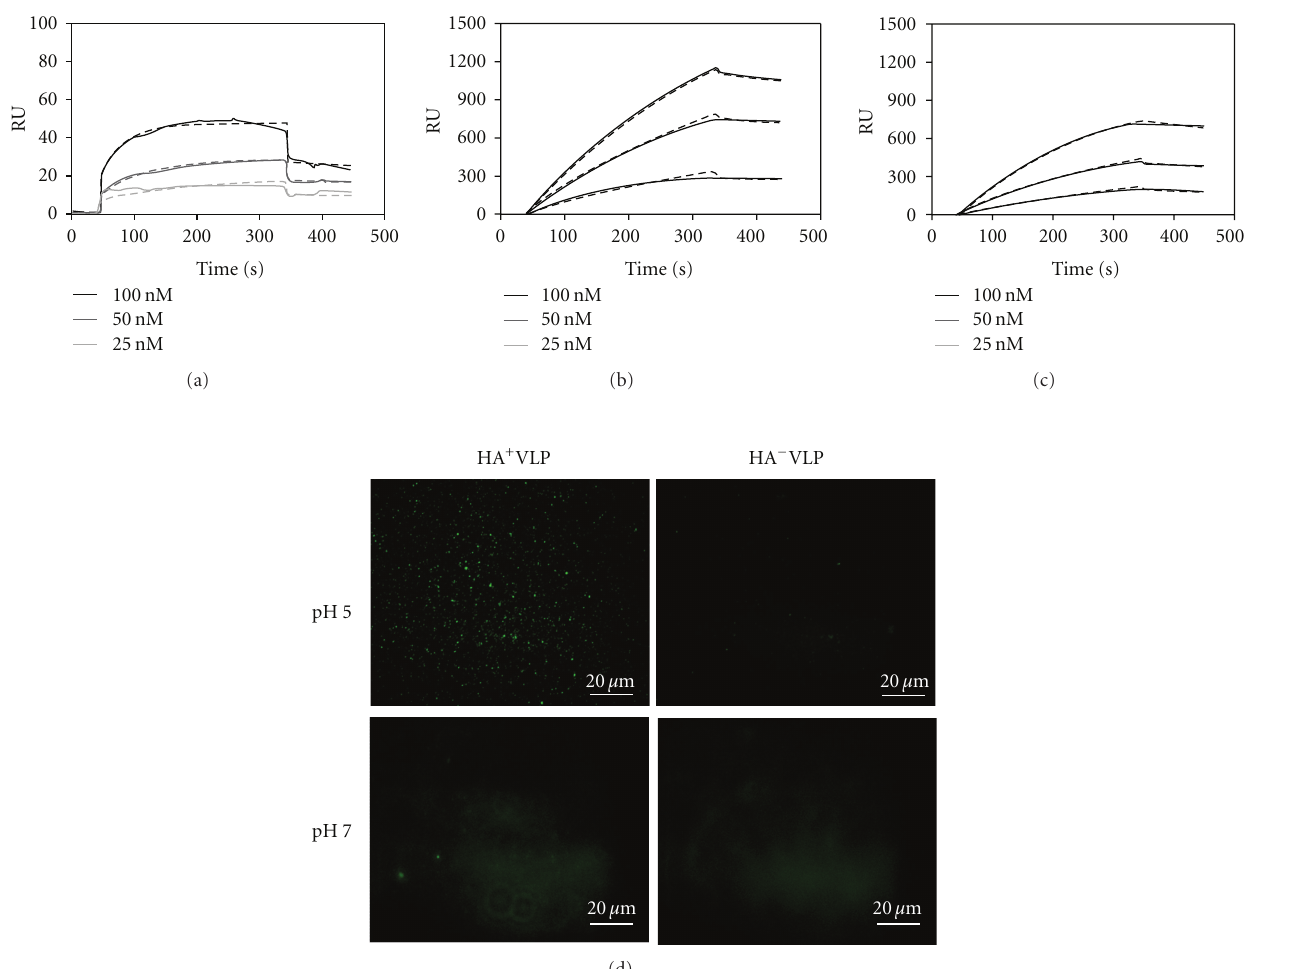
Figure 4: Conformational change of HA on VLPs triggered by low pH. The dissociation constant of mAb IIF4 with HA + VLPs or HA − VLPs at neutral or acidic pH was determined by SPR technique: (a) mAb IIF4 bound to HA + VLPs at pH 7.4; (b) mAb IIF4 bound to HA + VLPs at pH 5.0; (c) mAb IIF4 bound to HA − VLPs at pH 5.0. (d) displays immunofluorescence staining of VLP by mAb IIF4. See “Materials and Methods” for